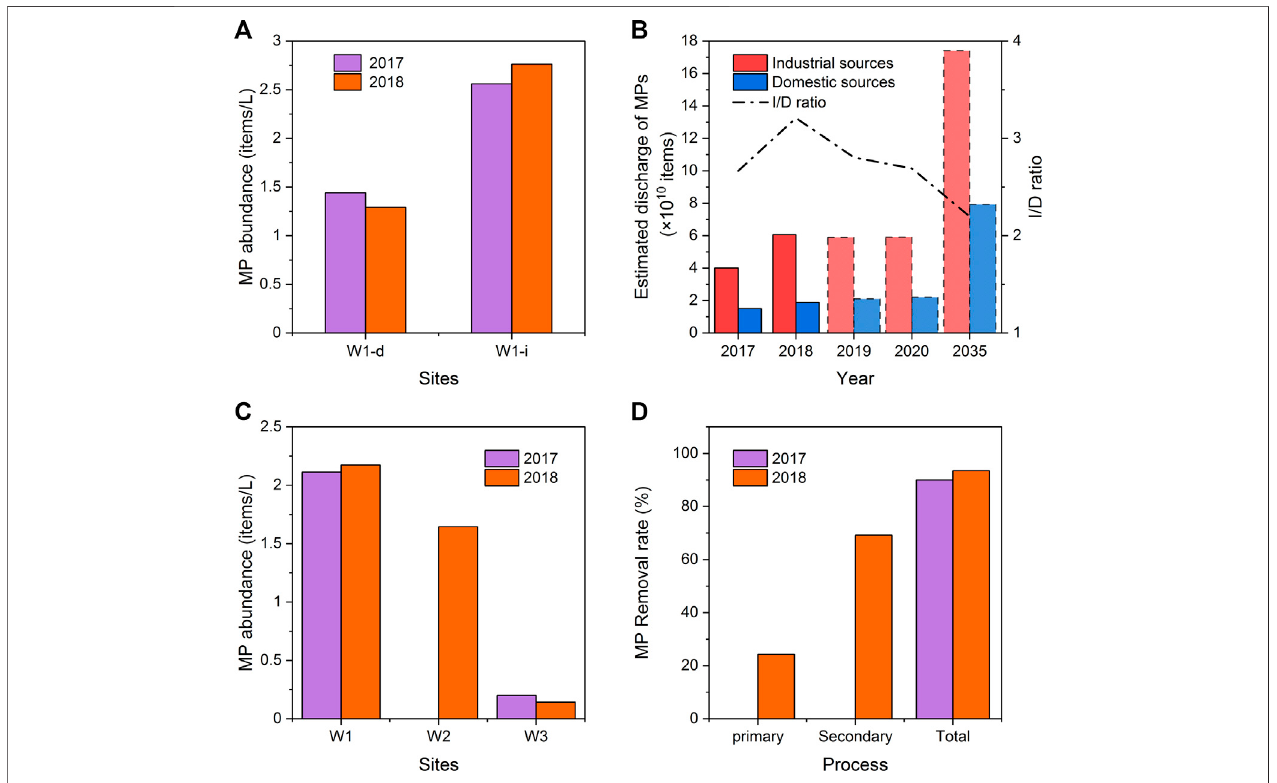
FIGURE 2| The abundance (A) , annual estimated discharge (B) ofMPs in industrial and domestic wastewater. The abundance of MPs (C) and removal rate (D) in different processes of Haicang WWTP.